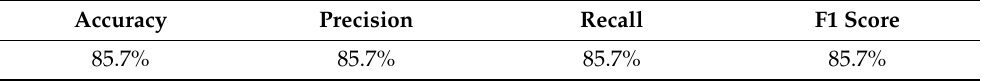
Table 2. The proposed CNN’s classification metrics in terms of mean value.